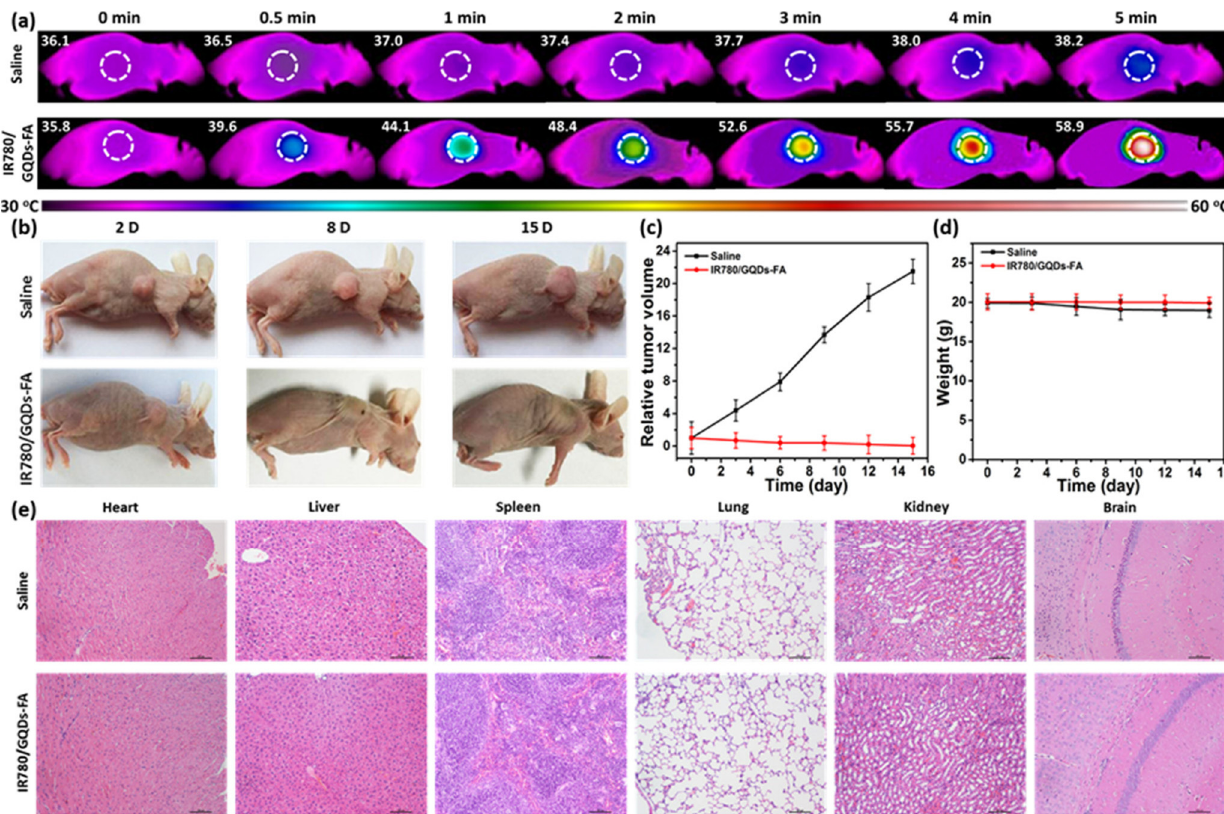
Figure 11. ( a ) Tumor thermal images of temperature variations after intravenous injection of saline and IR780/GQDs-FA with laser irradiation; ( b ) Photos of the tumor-bearing mice after treatments. Tumor volume ( c ) and body weight ( d ) curves of the tumor-bearing mice. ( e ) Histological evaluation of tissues from the mice treated with saline and IR780/GQDs-FA. Each organ was sliced for hematoxylin and eosin (H&E) staining. Reproduced from Ref. [102] with permission from